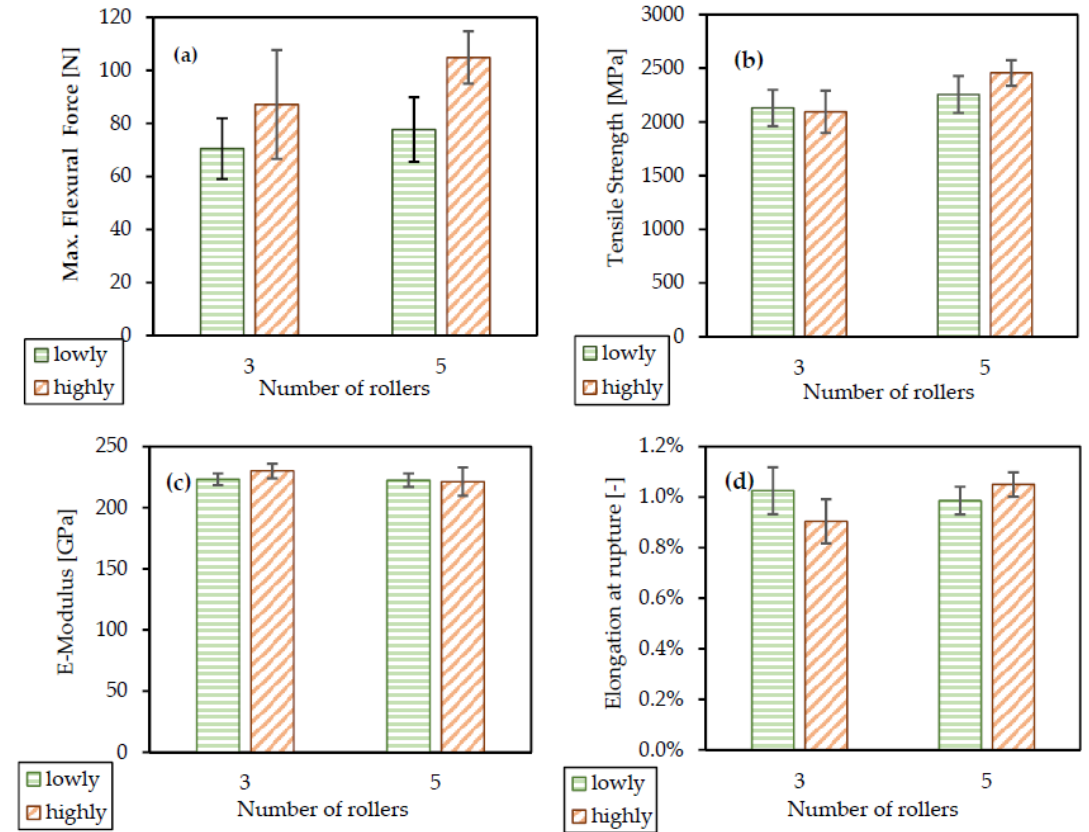
Figure 11. ( a ) Maximum flexural force, ( b ) Tensile strength, ( c ) E-modulus and ( d ) Elongation at rupture of MCFs, in dependence on the roller assembly.